Question: Write a single sentence explaining what this figure depicts.
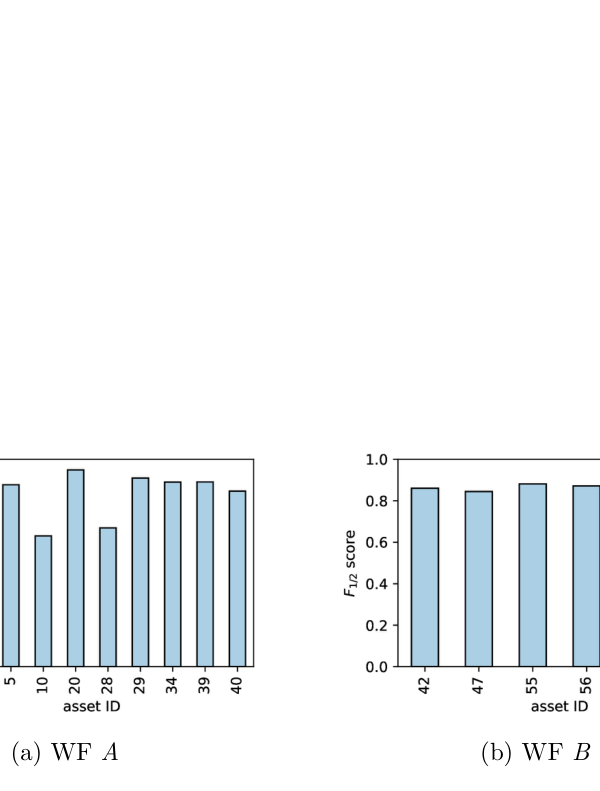
Answer: Performance of the baseline models.